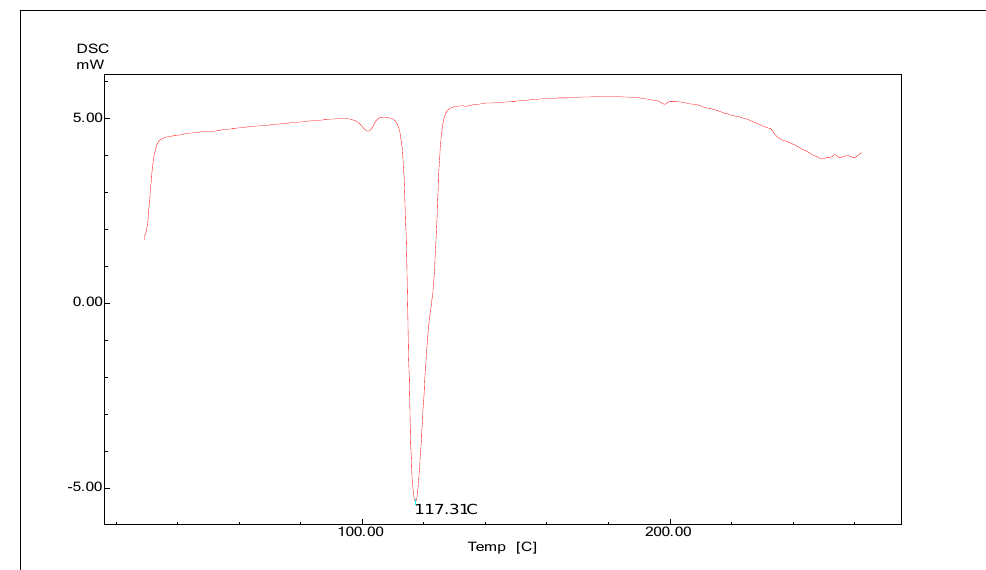
Figure 8. DSC thermogram of mirtazapine pure powder